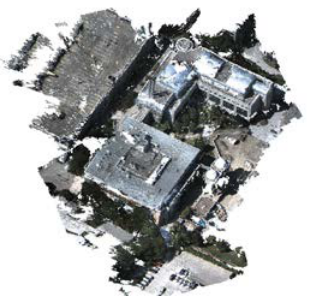
Figure 5. Concept of the 3D scale-invariant keypoint detector.